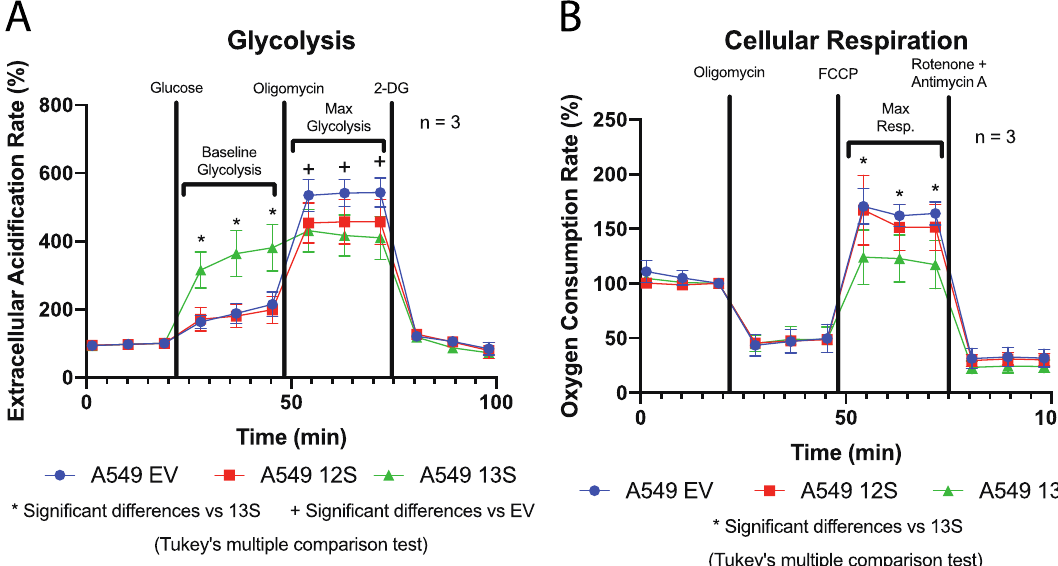
Figure 1. A549-13S cells have a unique functional glycolytic and oxidative phosphorylation metabolism when compared to A549-12S and A549-EV cells. ( A ) Seahorse XFe24 assay of extracellular acidification rates, a readout of glycolysis. Extracellular acidification rates were highest in A549-13S cells after addition of glucose, which is a reflection of the baseline glycolytic rate after stimulation. However, A549-EV cells had the highest maximum extracellular acidification rates after addition of oligomycin, which forces maximal glycolysis by inhibition of ATP synthase. There were no differences in response after the addition of 2-deoxyglucose (2-DG) to shut down glycolysis and end the experiment. * = p < 0.05 in a comparison between A549-13S and either A549-12S or A549-EV cell lines. + = p < 0.05 in a comparison between A549-EV and either A549-12S or A549-13S cell lines. ( B ) Seahorse XFe24 assay of oxygen consumption rates, a readout of oxidative phosphorylation. The amount of cellular respiration dedicated to ATP production was no different between the cell lines as indicated by oligomycin treatment. Maximal oxygen consumption rates, induced by carbonyl cyanide-4-(trifluoromethoxy)phenylhydrazone (FCCP) which decouples the mitochondria, were lowest in A549-13S cells. There were also no differences between the cell lines after the addition of rotenone and antimycin A used to terminate the experiment. * = p < 0.05 in a comparison between A549-13S and either A549-12S or A549-EV cell lines. 2-DG, 2-deoxyglucose; FCCP, carbonyl cyanide-